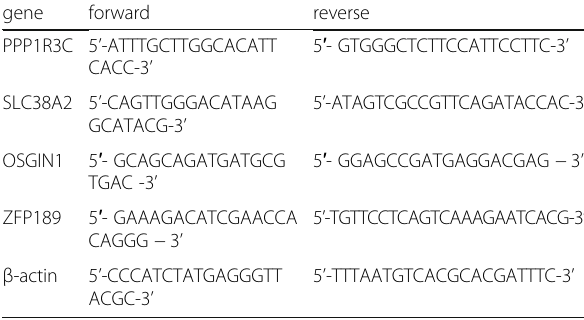
Table 1 The primers sequence involved in the paper